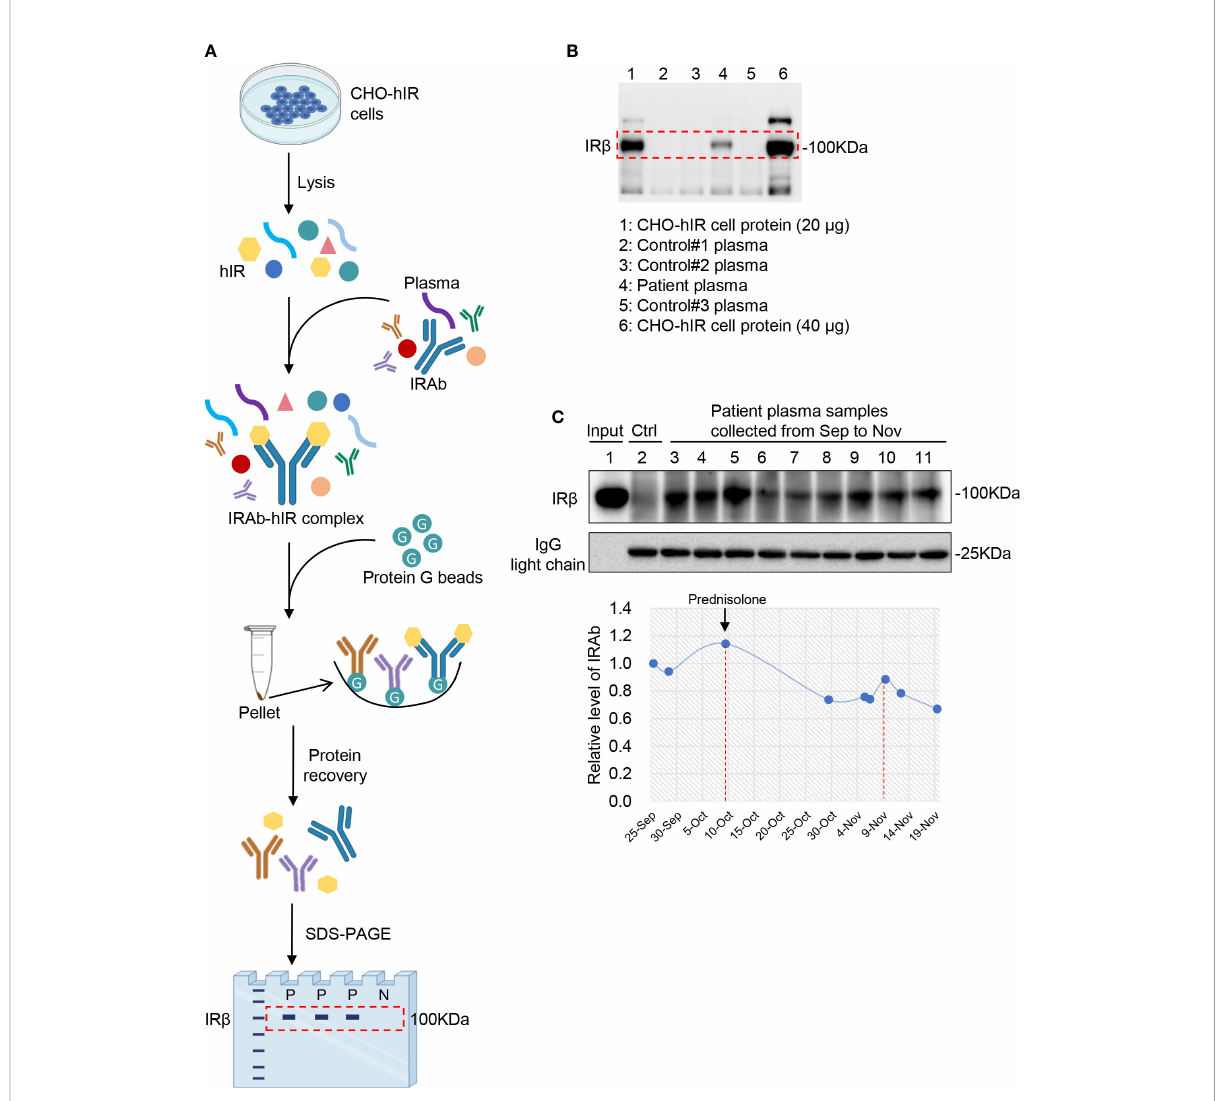
FIGURE 2 Detection of IRAb in the patient plasma. (A) Diagram showing the principle and procedures for immunoprecipitation assay for IRAb detection. (B) Human insulin receptor protein was detected in the precipitates from patient plasma sample (lane 4) but not from three control plasma samples (lane 2, 3, 5). CHO-hIR cell lysates were loaded as positive control (20µg total protein for lane 1 and 40µg total protein for lane 6). Similar results were obtained from another two independent experiments. IR b , insulin receptor b subunit. (C) IRAb titers were dynamically monitored in this patient from September to November. The relative IRAb titers were calculated by densitometric quanti fi cation of IR b levels and normalized to levels of plasma IgG light chain. Representative result from three independent experiments was